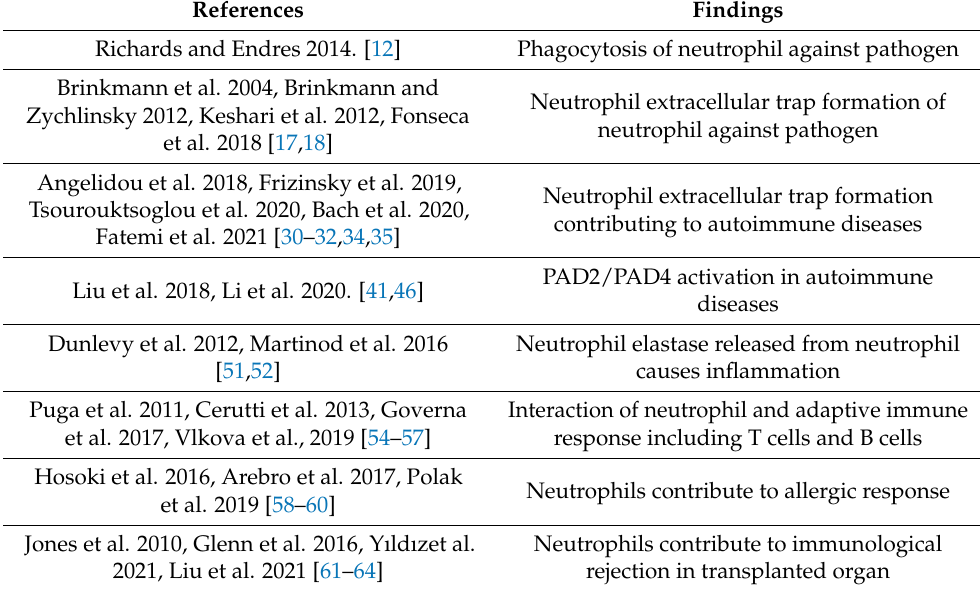
Table 1. Role of neutrophil in